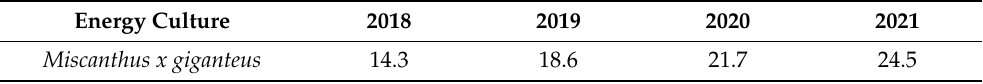
Table 1. Yield of Miscanthus x giganteus on black soil in 2018–2021, dry weight t/ha.